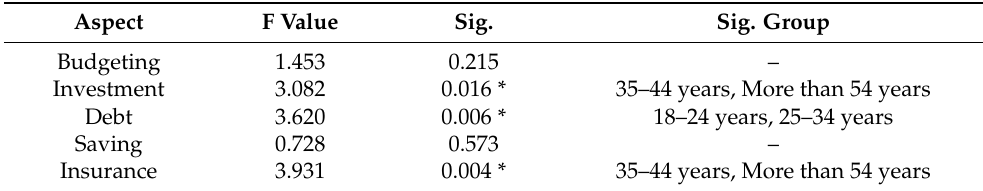
Table 10. Differences according to age using the ANOVA test ( n = 887). Aspect F